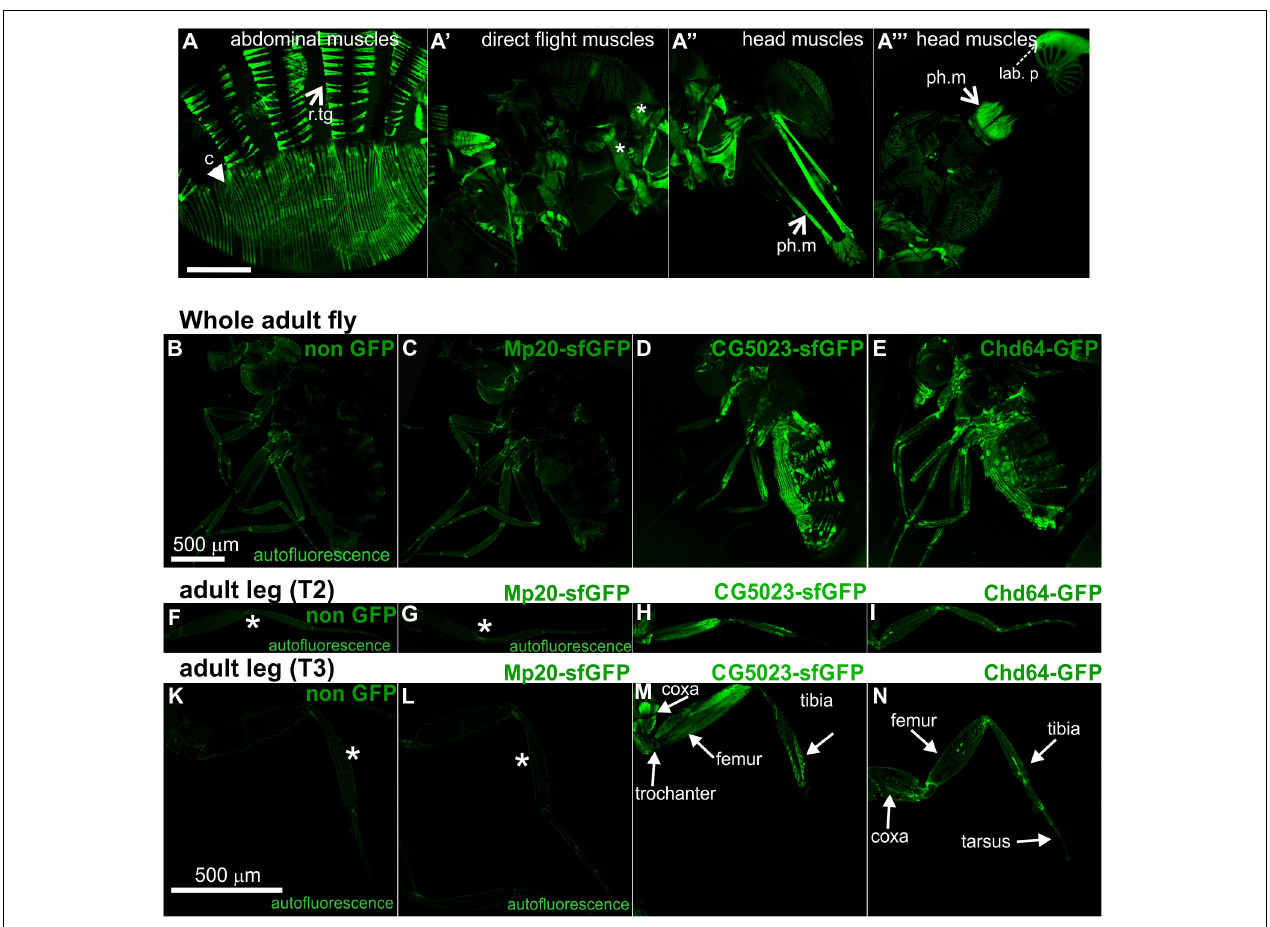
FIGURE 8 | Transgelin protein expression in Drosophila adults. (A–N) Confocal micrographs of isolated adult tissues expressing fluorescently tagged transgelin proteins that reveal their endogenous pattern of distribution. (A–A (cid:48)(cid:48)(cid:48) ) Adult fly expressing CG5023-YFP in panel (A) all the abdominal muscles, (A (cid:48) ) in a subset of thoracic muscles (asterisks), and (A (cid:48)(cid:48) ,A (cid:48)(cid:48)(cid:48) ) both the pharyngeal and labial pulp muscles in the head. (B–E) Confocal micrographs of living adult flies imaged under identical settings to demonstrate, (B) tissue autofluorescence, (C) absence of Mp20-GFP in adult tissues, (D) expression of CG5023-sfGFP in abdominal muscles, and (E) Chd-GFP expression in various internal organs. (F–I,K–N) Confocal micrographs of isolated adult (F–I) T2 and (K–N) T3 legs. CG5023-sfGFP displays robust fluorescence signal in specific indicated parts of the adult legs. The strain used in panels (B,F,K) was w,f and did not express a GFP-tagged gene. Each image is representative of at least six different imaged adult flies and isolated adult legs of the same genotype. r.tg, retractors of tergites; c, compressors of abdomen; ph.m, pharyngeal muscles; lab p, labial pulp. Scale bars: 500 µ